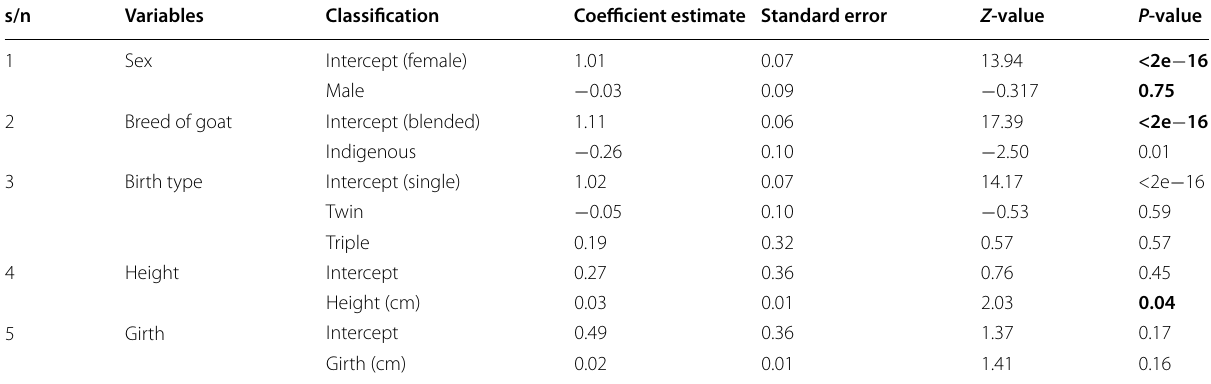
Table 2 The association of weight with the disease’s occurrence, birth type, sex, and breed of goats s/n